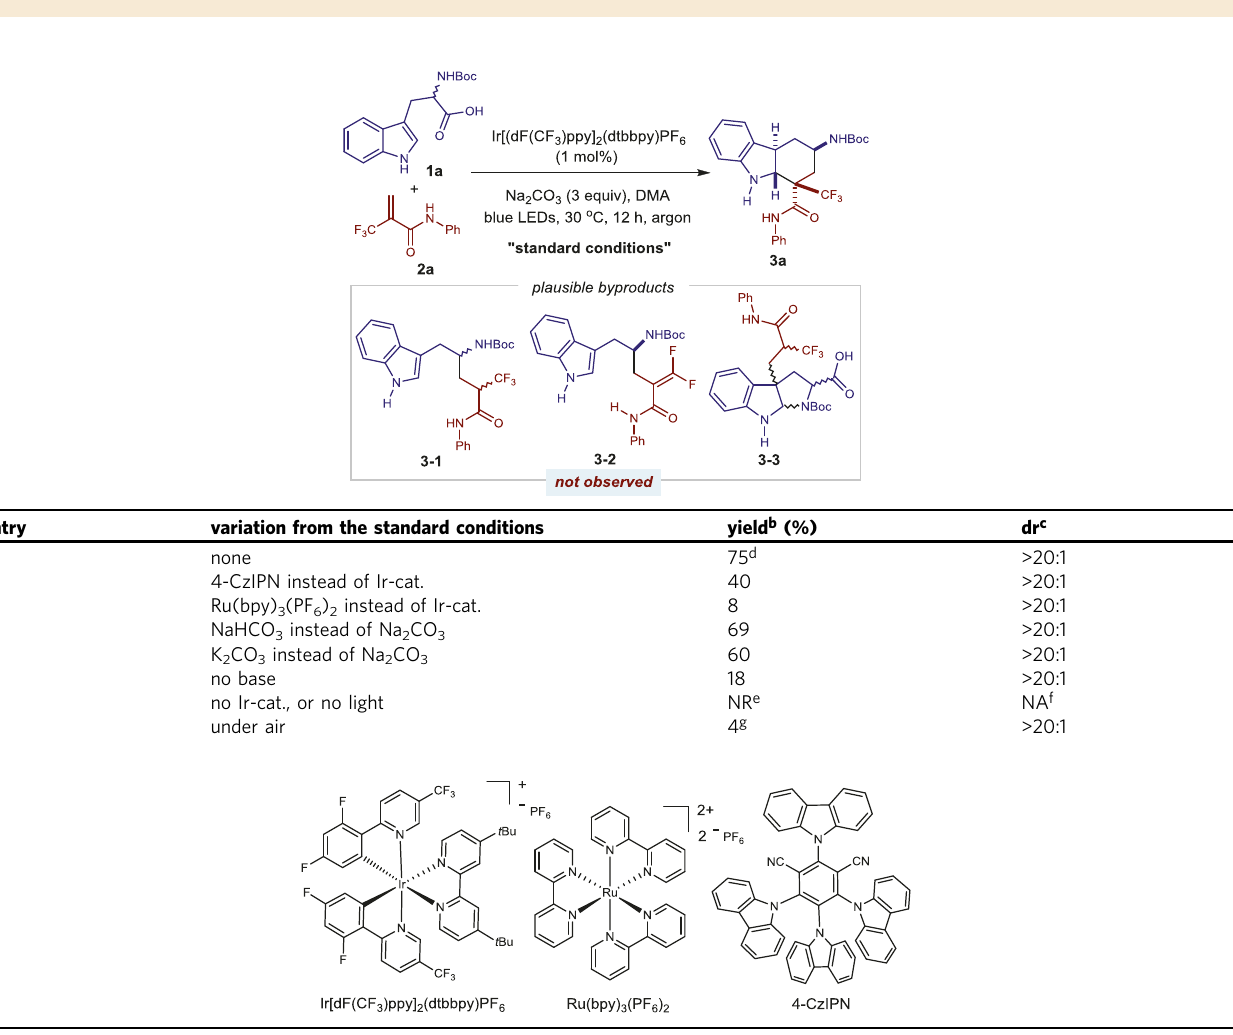
Table 1 Optimization of the reaction conditions a